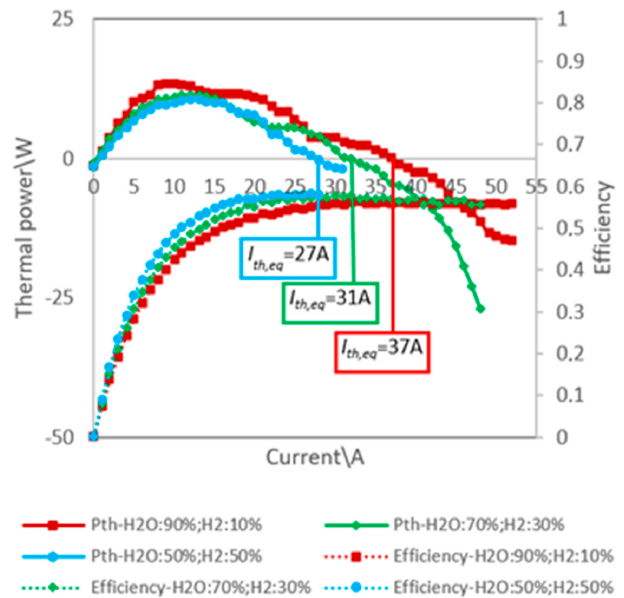
Figure 8. Trends of total thermal power and net production efficiency for the SOE stack fed by three steam mixtures and by air at varying the stack current.